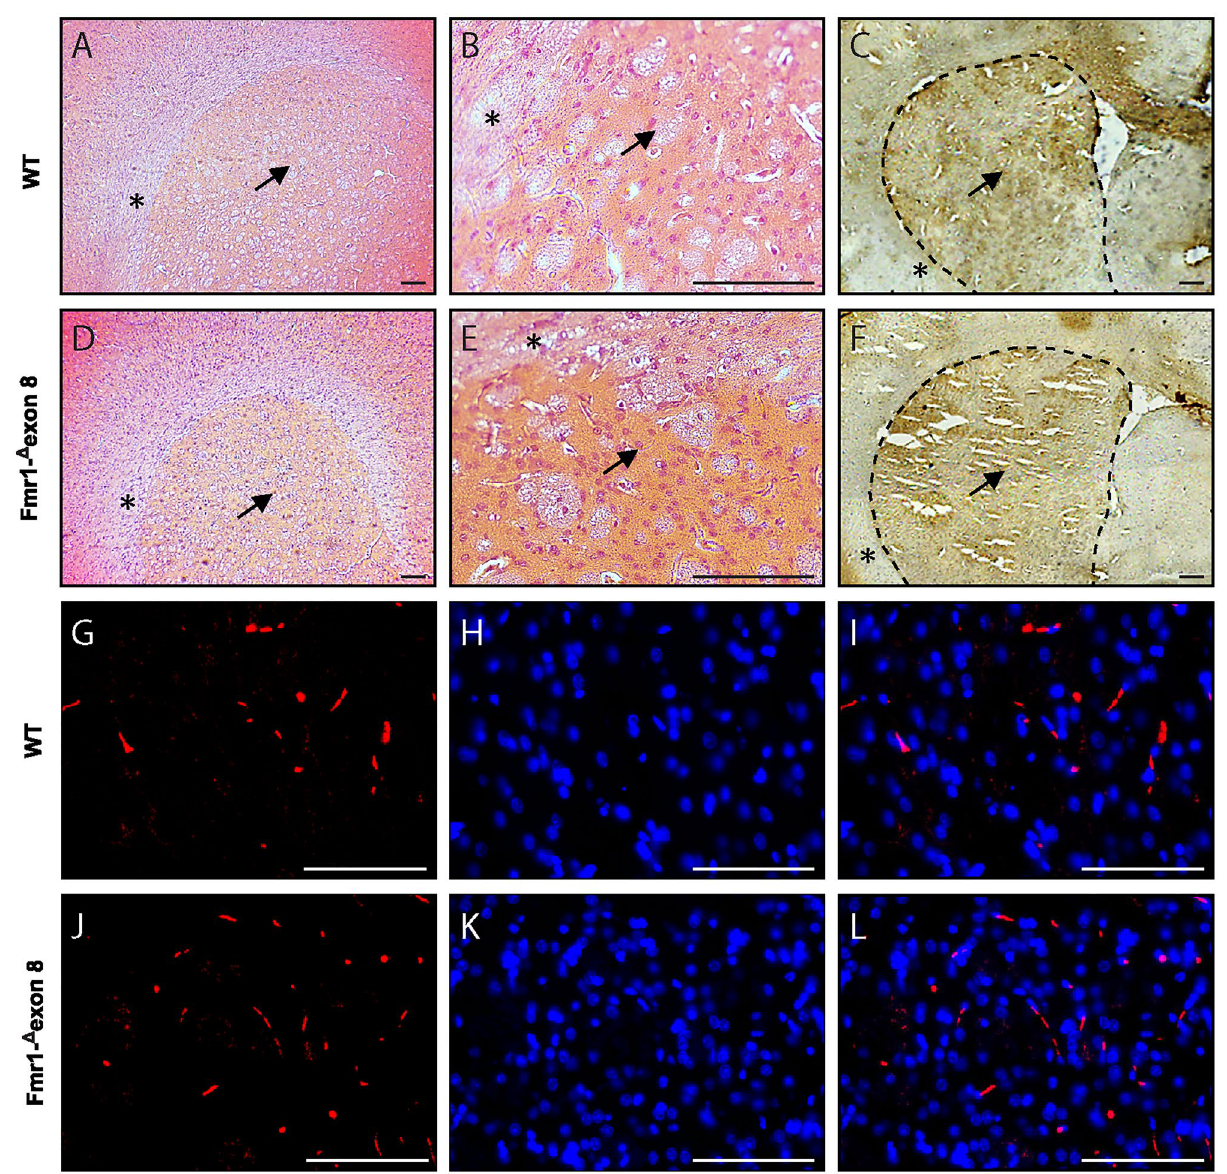
Figure 6. Histological and immunostaining assays. Microphotographs of hematoxylin and eosin staining of dorsal striatum of WT ( A and B ) and Fmr1- Δ exon 8 ( D and E ) rats at lower magnification (6X, A and D ) and higher magnification (40 × , B and E ). Representative DAT immunohistochemistry in the dorsal striatum of adult WT ( C ) and Fmr1- Δ exon 8 ( F ) rats. The dorsal striatum and surrounding corpus callosum are indicated with a black arrow and asterisks, respectively, both in histological and immunohistochemistry images. Scale-bar: 100 µm. DAT immunofluorescence and DAPI nuclear staining in the dorsal striatum of adult WT ( G–I ) and Fmr1- Δ exon 8 ( J–L ). Red DAT ( G and J ); blue DAPI ( H and K ); merge ( I and L ). Scale-bar: 100